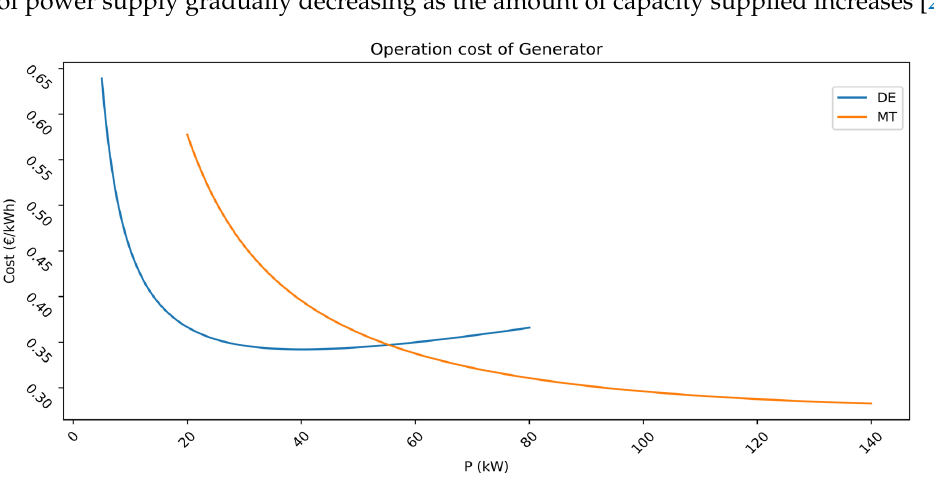
Figure 6. Cost of operation of the DE and MT in terms of the power supply.